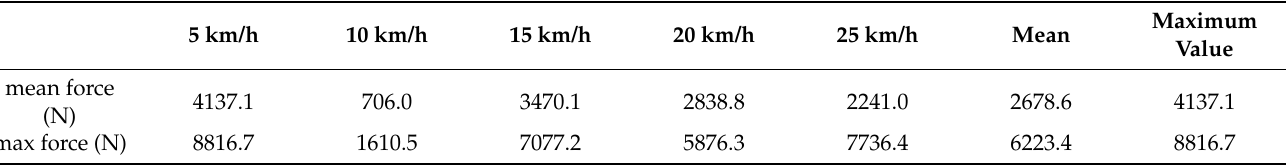
Table 4. Statistical characteristics of the 5 m span contact force curve.